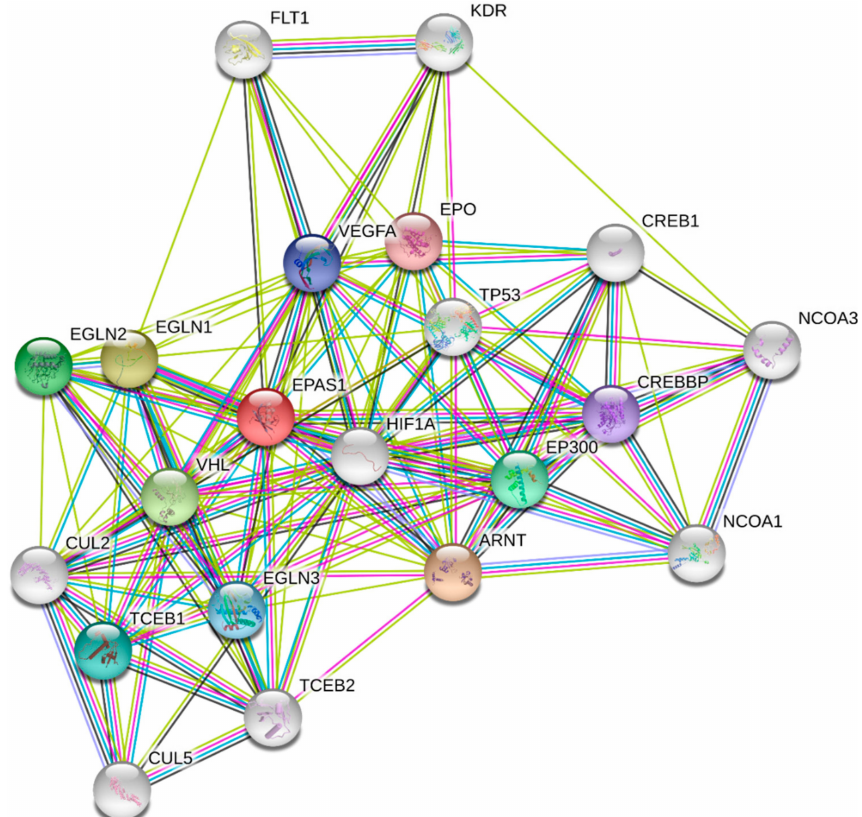
Figure 3. The protein–protein interaction network of HIF-1 α obtained from String v11 database [29]. The colored lines of the edges represent the existence of different types of evidence used in pre- dicting the associations (green: neighborhood evidence; blue: co-occurrence; purple: experimental evidence; light blue: database evidence; black: co-expression evidence). The HIF-1 α interacting proteins are (in alphabetical order): ARNT: aryl hydrocarbon receptor nuclear translocator; CREB1: cyclic AMP-responsive element-binding protein 1; CREBBP: CREB-binding protein; CUL2: cullin2; CUL5: vasopressin-activated calcium-mobilizing receptor 1; EPAS: endothelial PAS domain protein 1, HIF-2 α ; EGLN1: Egl nine homolog 1; EGLN2: Egl nine homolog 2; EGLN3: Egl nine homolog 3; EPO: erythropoietin; EP300: histone acetyltransferase p300; FLT1: vascular endothelial growth factor receptor 1; KDR: vascular endothelial growth factor receptor 2; NCOA1: nuclear receptor